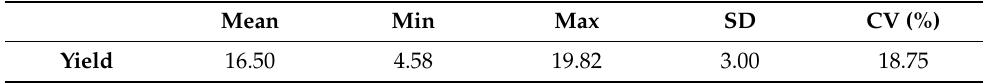
Table 3. Descriptive statistics of the yield